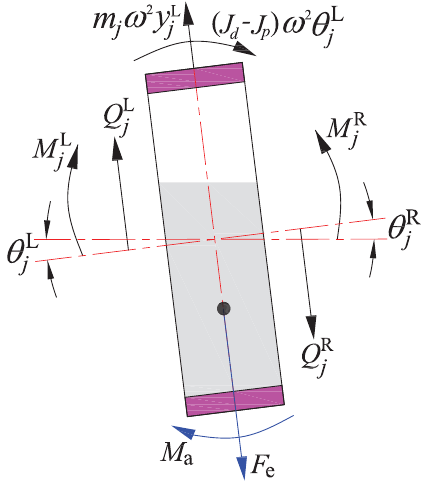
Figure 9. Mechanics analysis of tilt disk with concrete loading.